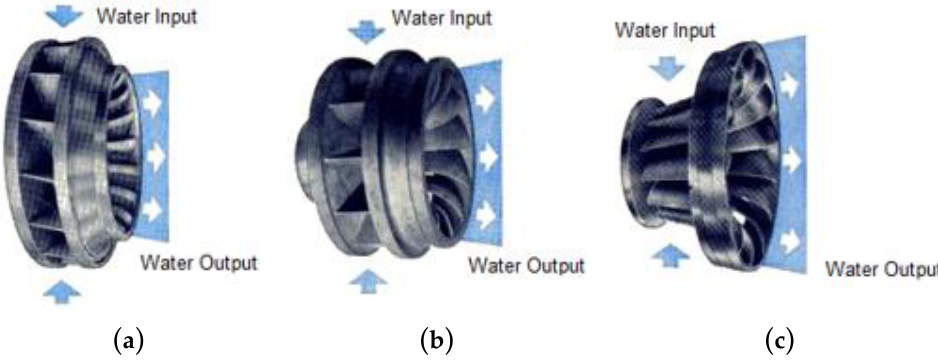
Figure 5. Low specific speed ( a ), normal specific speed ( b ), and high specific speed ( c ) Francis runners suitable for high, average, and low heads, respectively.